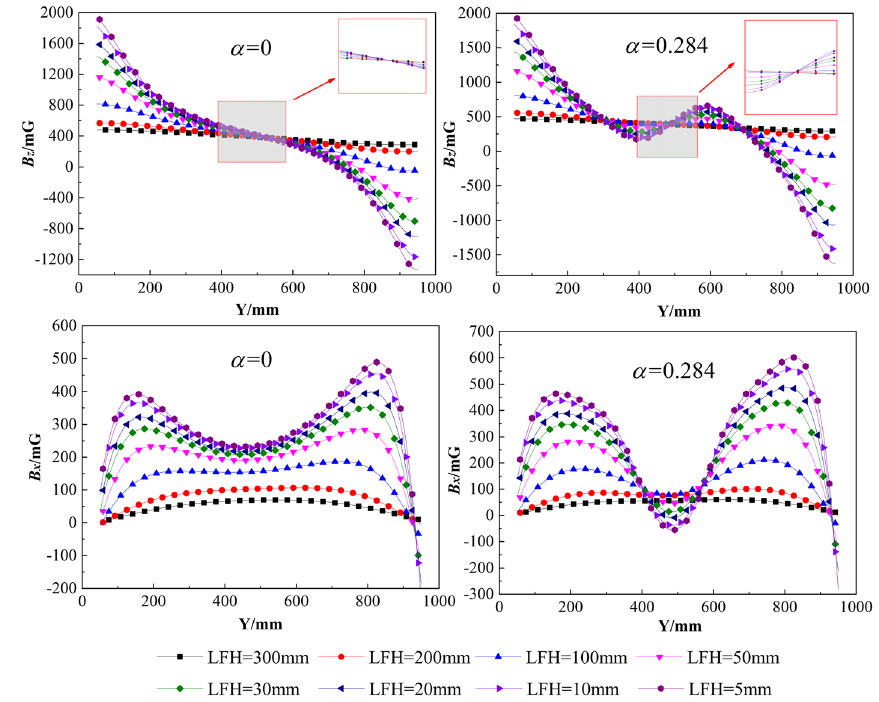
Fig. 8 Bz curve and Bx curve of specimen 14# before and after corrosion